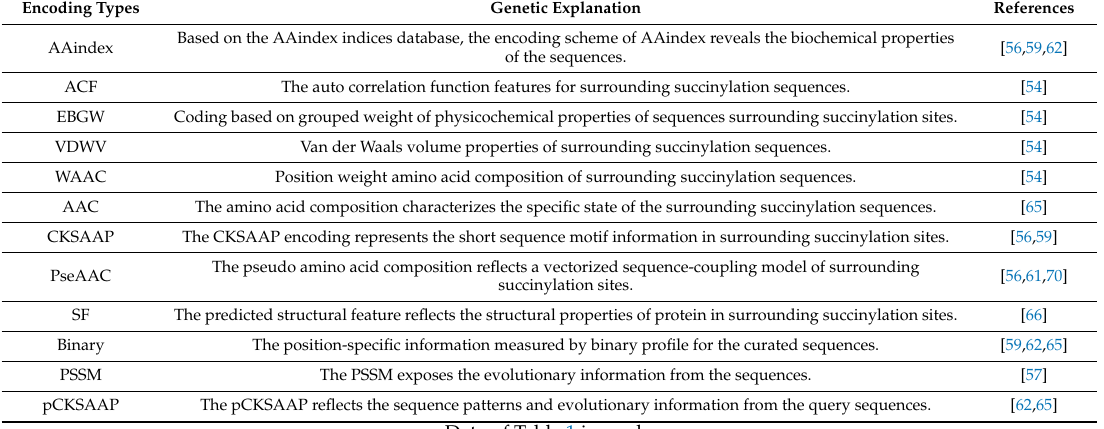
Table 3. Statistics of feature encoding schemes used in the aforementioned succinylation site prediction